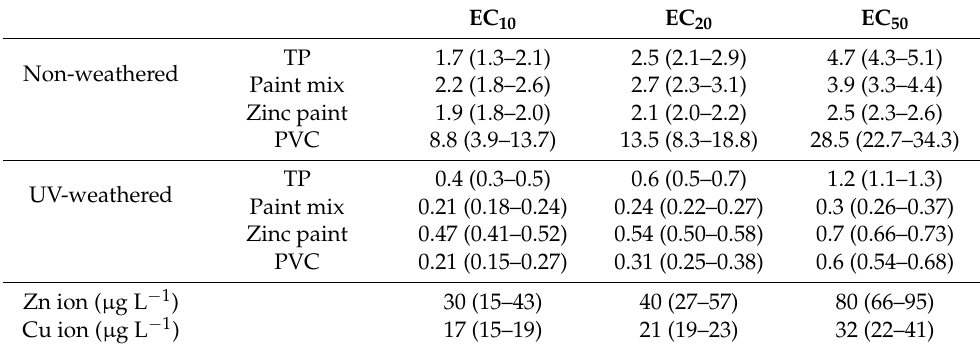
Table 2. EC values expressed as % leachate, with the lower and upper confidence intervals of the EC values included. The EC values of single copper and zinc ions are expressed in micrograms per liter.